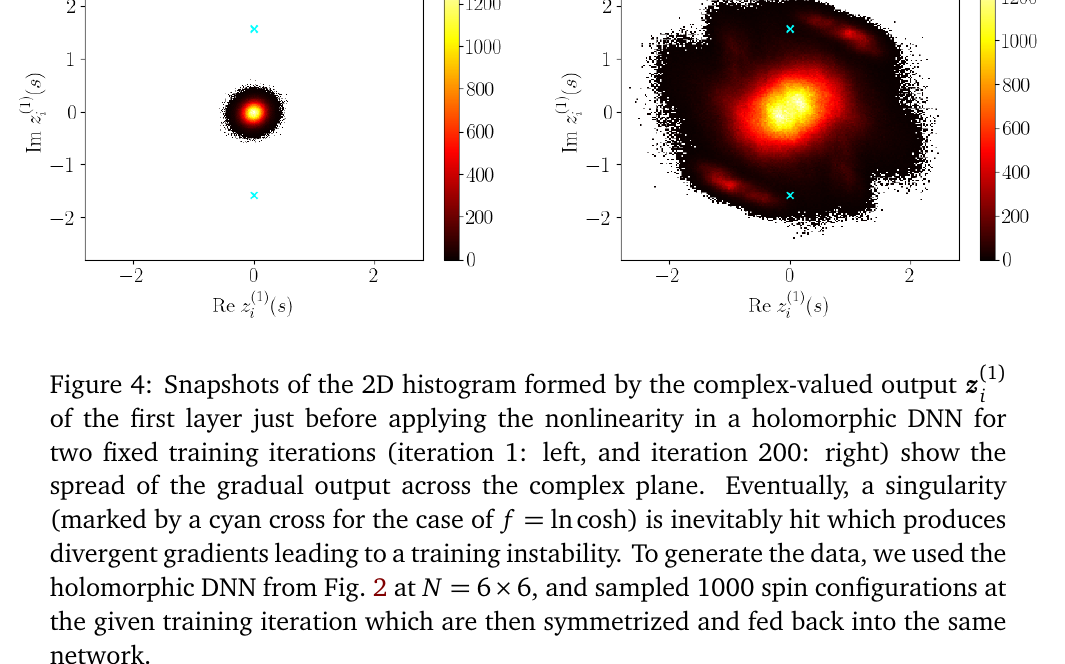
Figure 4: Snapshots of the 2D histogram formed by the complex-valued output z of the first layer just before applying the nonlinearity in a holomorphic DNN for two fixed training iterations (iteration 1: left, and iteration 200: right) show the spread of the gradual output across the complex plane. Eventually, a singularity (marked by a cyan cross for the case of f = lncosh) is inevitably hit which produces divergent gradients leading to a training instability. To generate the data, we used the holomorphic DNN from Fig. 2 at N = 6 × 6, and sampled 1000 spin configurations at the given training iteration which are then symmetrized and fed back into the same